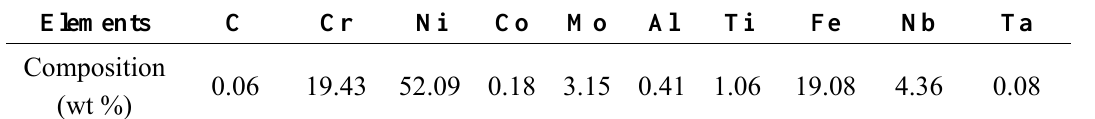
Table 1. Chemical composition of nickel-based superalloy.